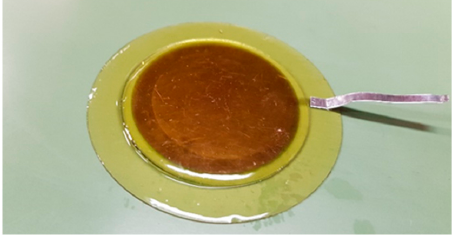
Figure 3. Dual layer epoxy sample with a 30 nm thickness gold electrode in-between layers.